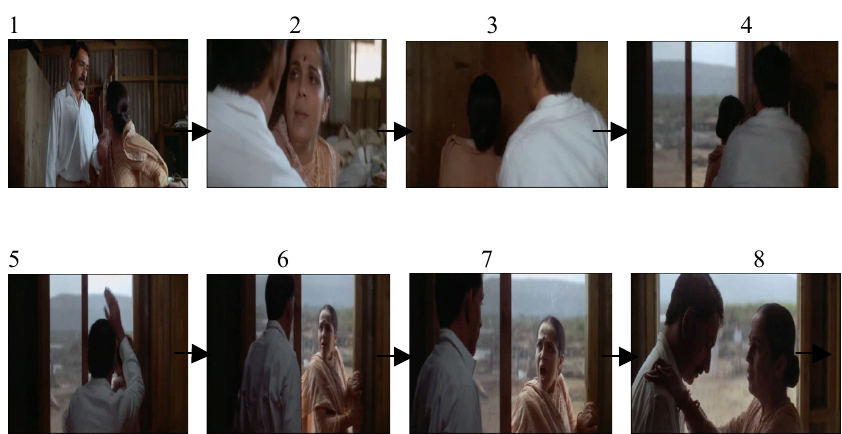
Photos: 2. c. Scene of Gandhi and Kasturba conflict in South Africa: Kasturba resents Gandhi’s violent exertion on